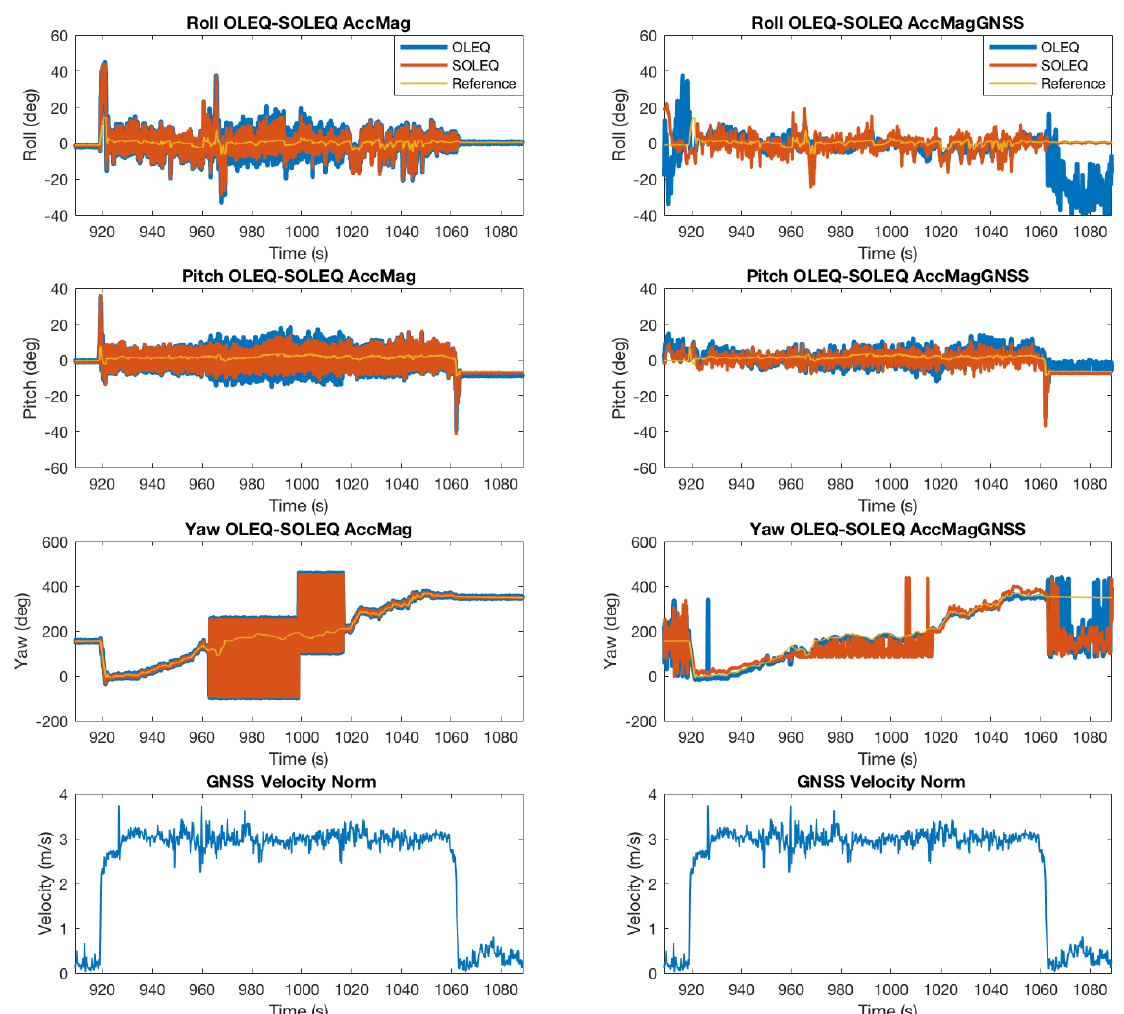
Figure 9. Attitude determination from the accelerometer, magnetometer and velocity output of the GNSS receiver, by means of OLEQ and